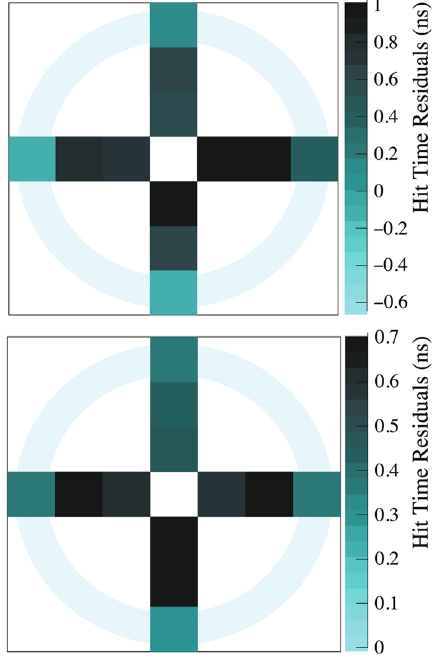
Fig. 9 Hit-time residuals versus PMT position for (Top) a single ring candidateeventand(Bottom)theaverageacrossalleventsinLAB/PPO. No hit selection is applied here, i.e. this is prior to application of the t c timing cut